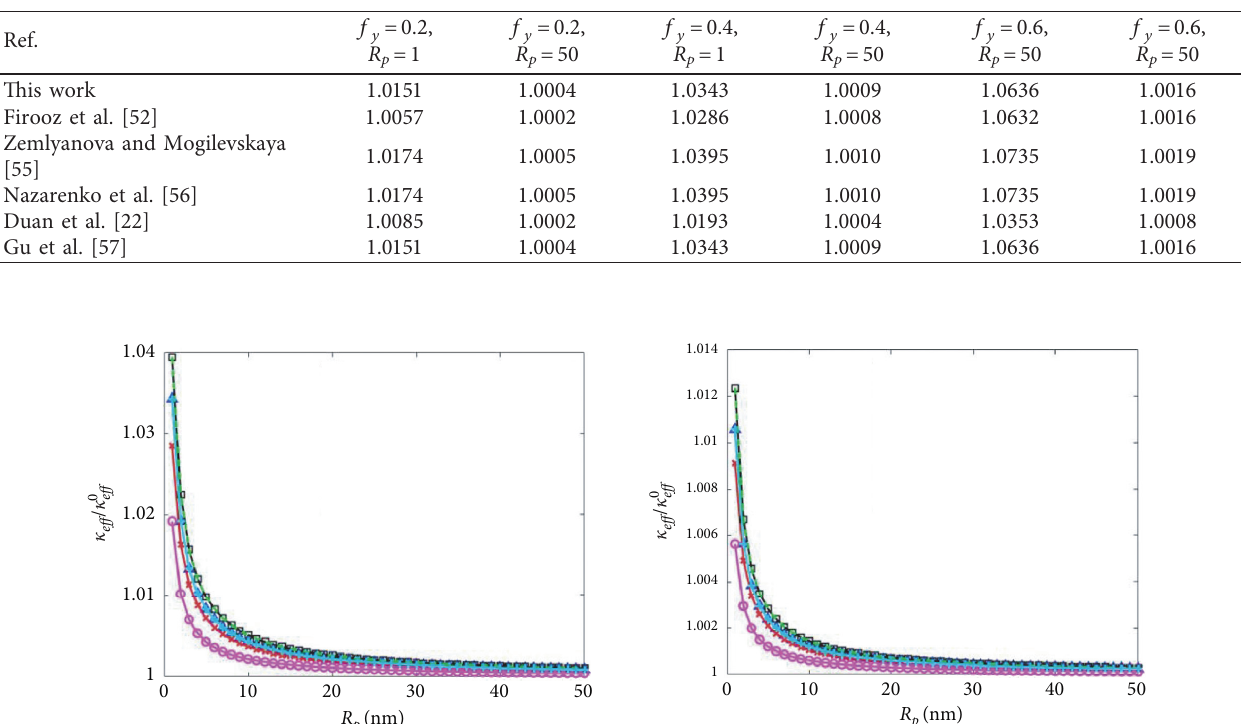
Table 3: Values of the κ eff0 ratio between different frameworks in the case where the contrast of elastic properties is fixed and the volume eff / κ fraction is varied.